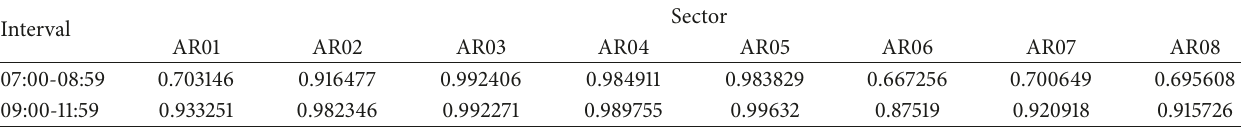
Table 5: Correlation test of traffic demand forecast of each sector in interval 07:00-11:59 on May 25, 2014.